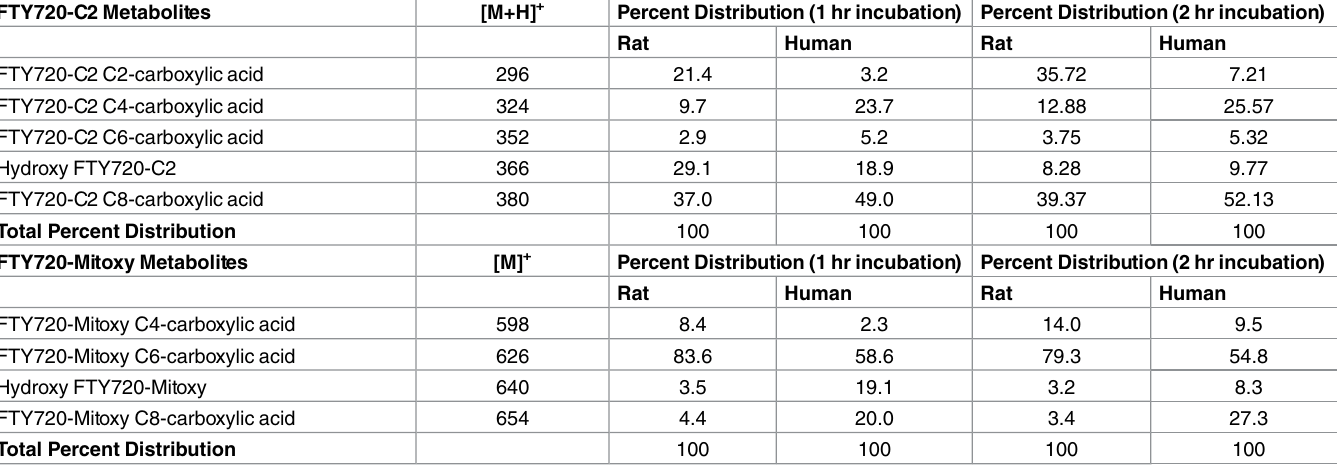
Table 6. RelativePercent Distribution of FTY702-C2 and FTY720-Mitoxy. FTY720-C2